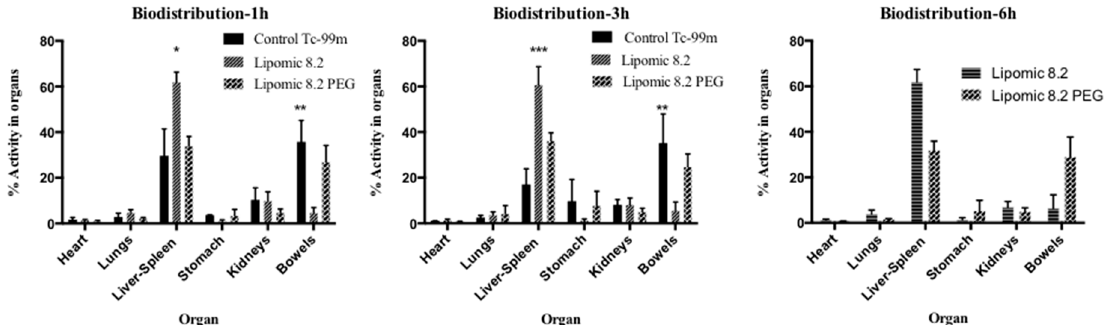
Figure 12. Uptake of 99m TcO 4 − , lipomics, and PEG lipomics as the percentage of activity present in each organ quantified from the images. The asterisks (*, **, ***) indicate statistical differences ( p < 0.05) from the other groups.